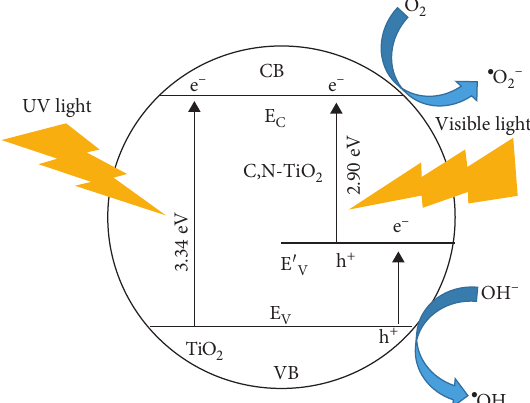
Figure 12: First-order kinetics for RhB degradation at different initial concentrations.